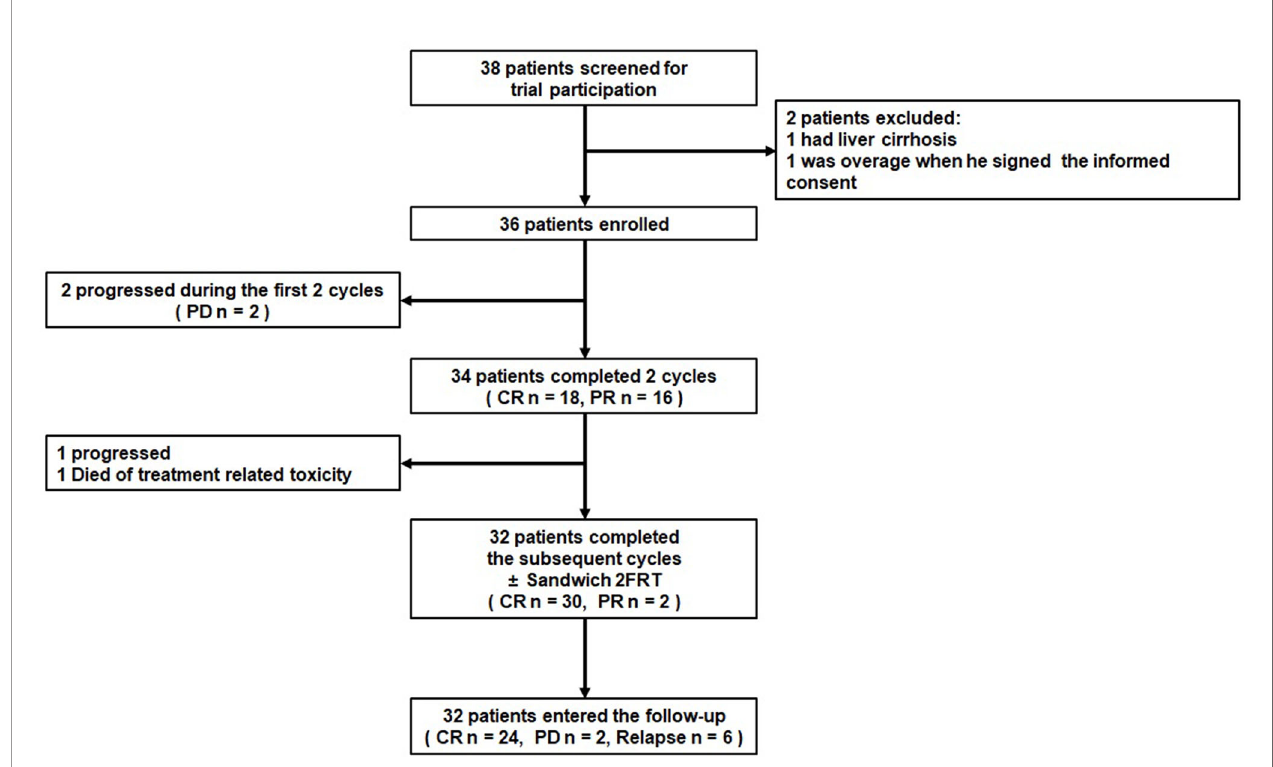
FIGURE 1 | Summary of outcomes in ENKTL treated with the GAD-M